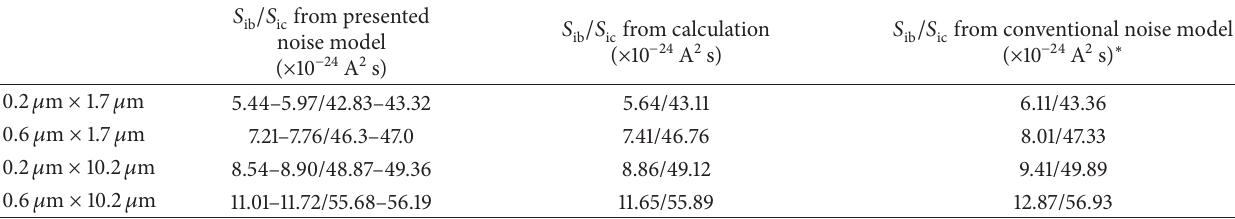
Table 4: Determined base and collector noise spectral density for different sized SiGe HBTs in the breakdown region of 𝑉 BE = 1.1 V and = 3.6 V. The results obtained from the presented noise model, calculation, and conventional model are compared. The variation is 𝑉 CE indicated for the results obtained from the presented model as the deviation of noise performance fitting is within